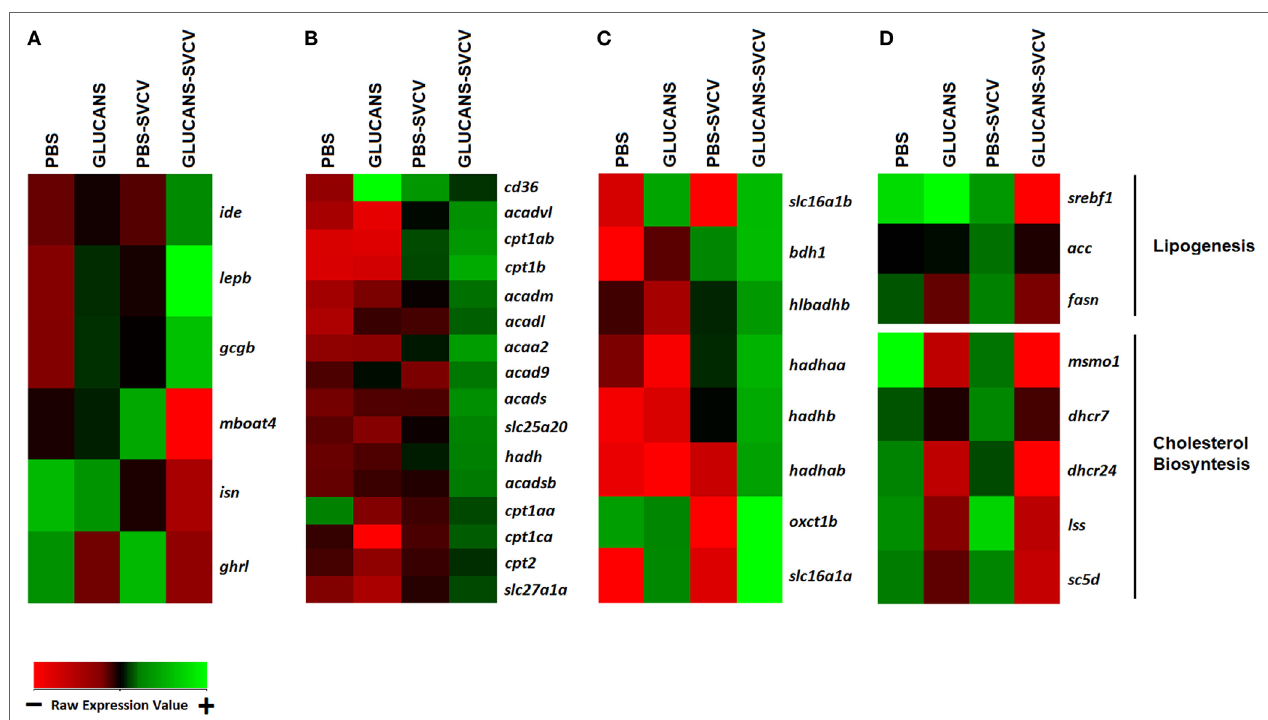
FigUre 5 | Heatmaps representing different components related to lipid metabolism and transport. (a) Hormone genes involved in lipid metabolism. (B) Genes encoding key components of fatty acid oxidation. (c) Ketolysis. (D) Lipogenesis and cholesterol biosynthesis. A color gradient scheme representing gene modulation (red: lower expression; green: higher expression) is shown on the